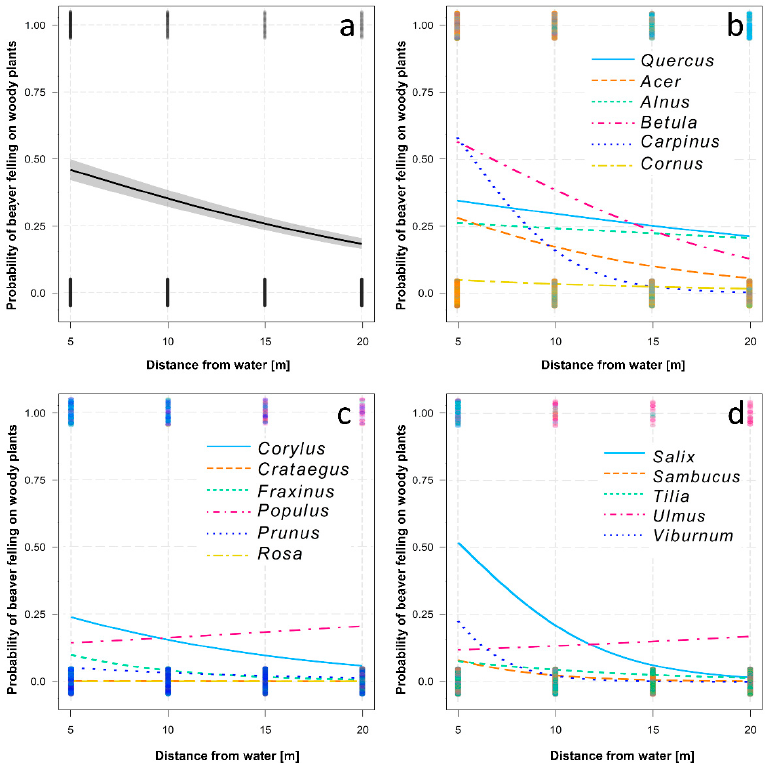
Figure 3. Probability of beaver felling on woody plants with increasing distance from the water: ( a ) overall model after controlling the other effects (spatial variance, diameter), ( b – d ) models for individual woody plant genera showing interactions.